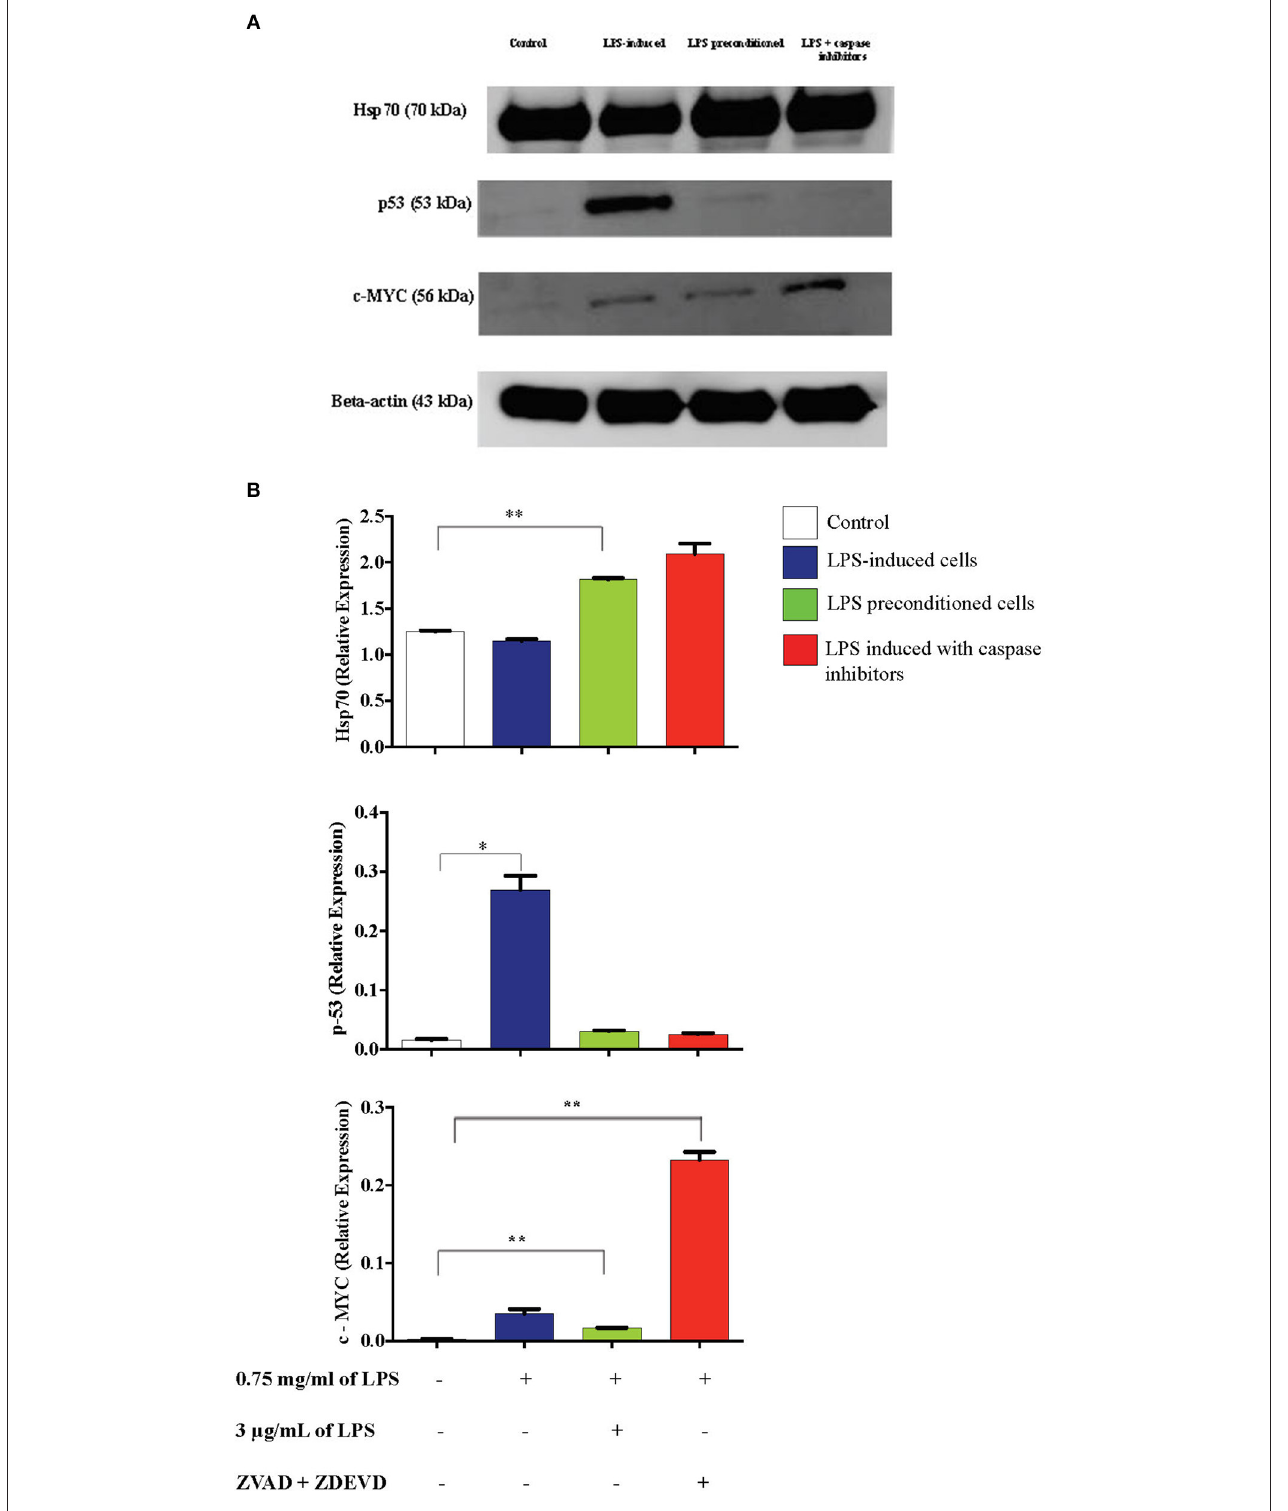
FIGURE 21 | Expressions of Hsp70, p53, and c-MYC. (A) The expressions of Hsp70, p53, and c-MYC were determined in whole cell lysates by western blotting. Band densities were measured by densitometric analysis, and data were normalized to the control and expressed as fold change relative to beta-actin. (B) Bars represent data from three independent experiments. Hsp70, p53, and c-MYC expressions in LPS-induced cells, LPS-preconditioned cells, and LPS-induced cells with caspase inhibitors were compared to the control. * p < 0.05, ** p < 0.01, as determined by one-way ANOVA with Bonferroni’s correction.